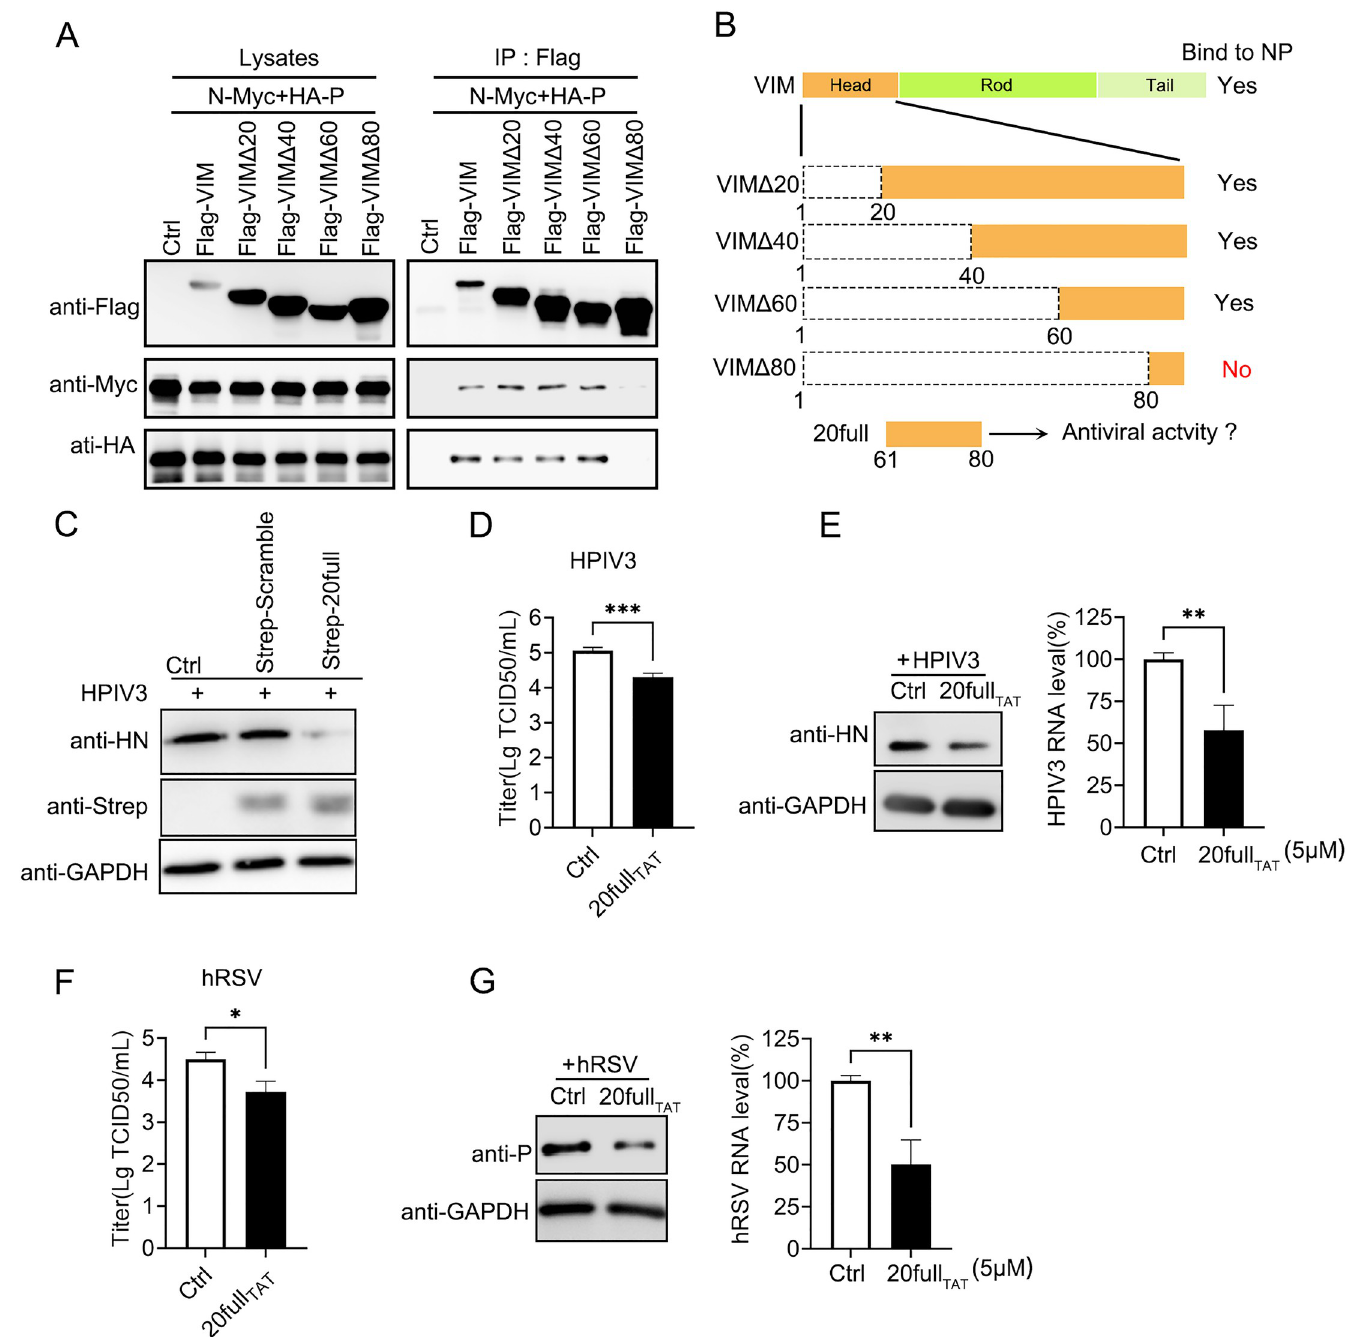
Fig 6. A peptide from the interaction site of VIM and N–P complex exhibits antiviral ability. (A) Interaction between VIM mutants and the N–P complex. VIM head domain-related mutant (VIM Δ 20, VIM Δ 40, VIM60, and VIM Δ 80) plasmids were transfected into HEK293T cells with N-Myc and HA–P plasmids. The cell lysates were subjected to an IP assay using anti-FLAG affinity gel. Lane 12 shows that the interaction between the N–P complex and VIM Δ 80 mutant was lost. (B) Graphical representation of the results of (A). (C) Strep-20 full inhibited HPIV3 infection. Strep-20 full plasmid or strep-scramble plasmid was transfected into A549 cells prior to HPIV3 infection (MOI = 0.1). Cells underwent lysis, and HPIV3 HN protein, strep-tagged proteins, and GAPDH were detected. (D) Titer of HPIV3 in supernatants from HPIV3 infected A549 cells which were treated with 20 full TAT peptide, and TAT was used as a control. (E) 20 full TAT peptide inhibited HPIV3 replication. A549 cells were infected with HPIV3 before being treated with 20 full TAT (HPIV3 MOI = 0.1). Both HPIV3 HN protein and viral RNA levels were detected. (F) Titer of hRSV in supernatants from hRSV infected A549 cells which were treated with 20 full TAT peptide, and TAT was used as a control.(G) The 20 full TAT peptide inhibited hRSV replication. A549 cells were infected with hRSV (MOI = 1) before being treated with 20 full TAT peptide and TAT peptide. Viral P protein and RNA levels were detected. Values are means ± SDs from three experiments. For panels D, E, F, and G, Student’s t test was used, and � p value < 0.05, �� p value < 0.01, ��� p value < 0.001, ���� p value < 0.0001, and ns = not